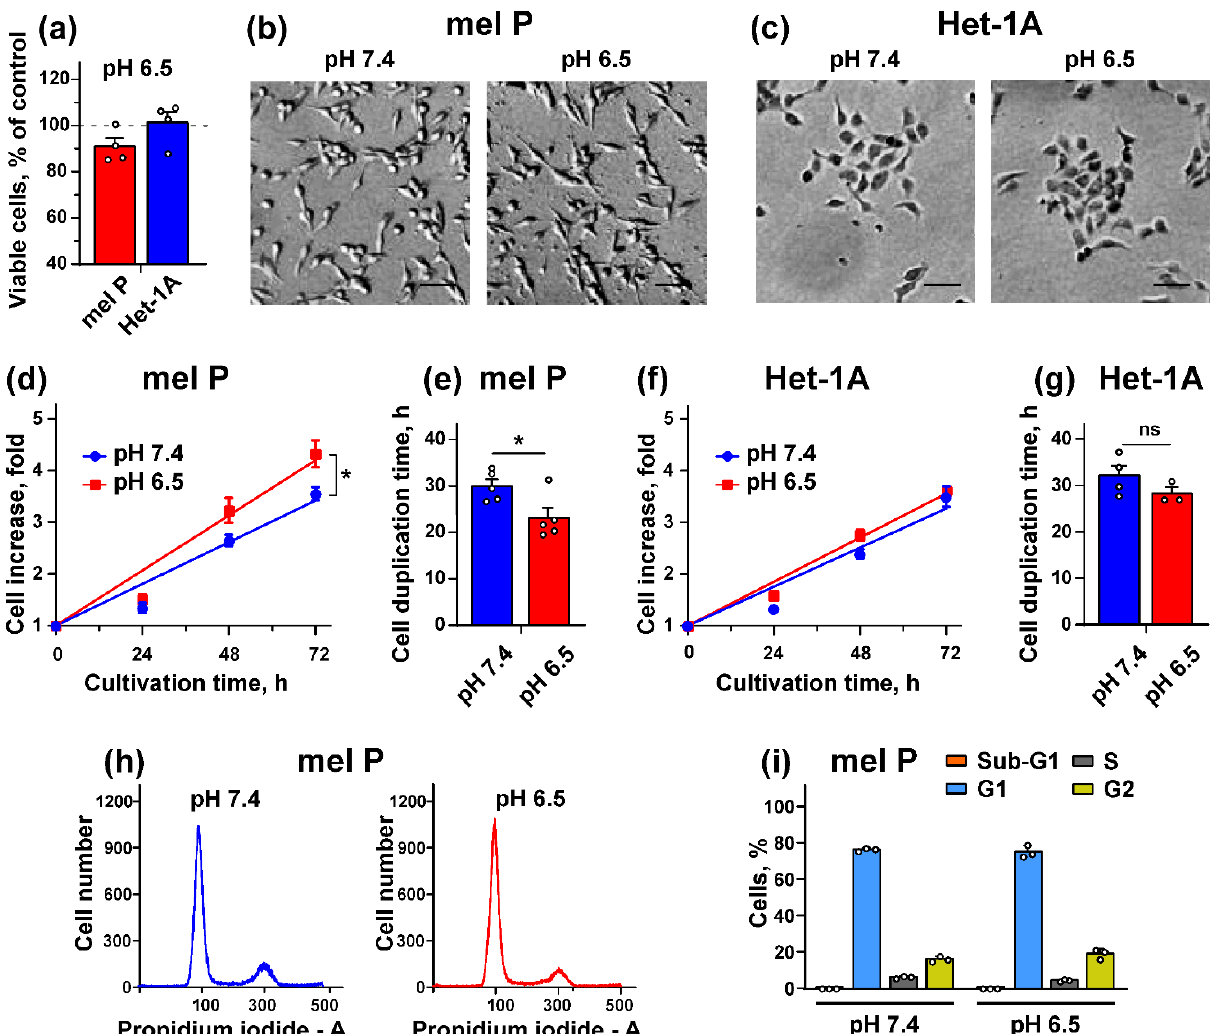
Figure 1. Effect of cell media acidification on growth of metastatic melanoma mel P cells and Het-1A keratinocytes. ( a ) Influence of cell media acidification on viability of mel P and Het-1A cells. Data were normalized to viability of cells cultivated at pH 7.4 (dashed line); ( b,c ) Influence of cell media acidification on morphology of mel P cells ( b ) and Het-1A cells ( c ), scale bar 25 µ m; ( d ) Growth dynamics of mel P cells upon cultivation at pH 7.4 and 6.5 ( n = 5). * ( p < 0.05) indicates significant difference between regression line slopes by ANCOVA test; ( e ) Duplication time of mel P cells cultivated at pH 7.4 and 6.5 ( n = 5). * ( p < 0.05) indicates significant difference between data groups by two-tailed t -test; ( f ) Growth dynamics of Het-1A keratinocytes cultivated at pH 7.4 and 6.5 ( n = 3–4); ( g ) Duplication time of Het-1A keratinocytes cultivated at pH 7.4 and 6.5 ( n = 3–4); ( h ) Representative nuclei population distribution of mel P cells cultivated at pH 7.4 and 6.5; ( i ) % of cells in each cell cycle phase. Data are presented as % of cells in each cell cycle phase ± SEM ( n = 3).